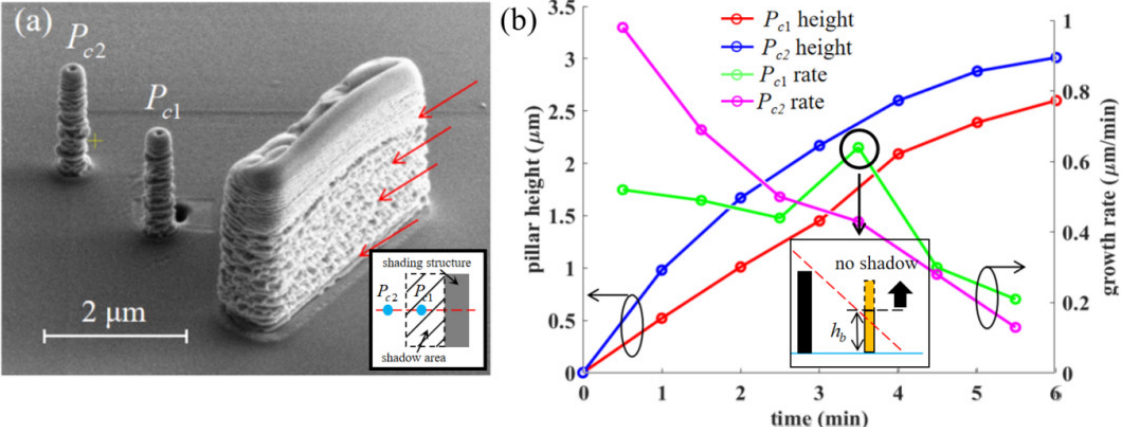
Figure 5. ( a ) The experimental results of pillars grown at 2.5 μm and 5 μm behind the shading structure with a size of 1.7 μm × 6.5 μm × 4.0 μm; ( b ) the time-dependent height and growth rate curves of the pillars. The red arrows indicate the precursor gas flow.